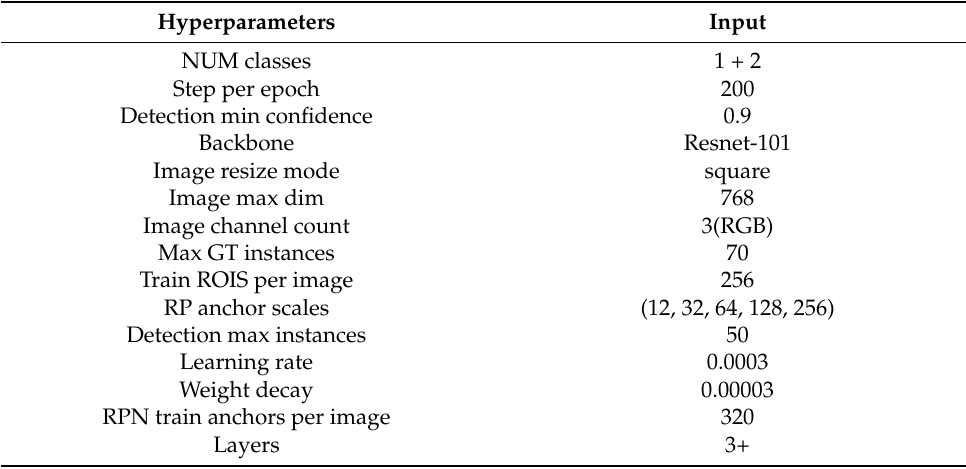
Table 2. Values of Cascade Mask R-CNN